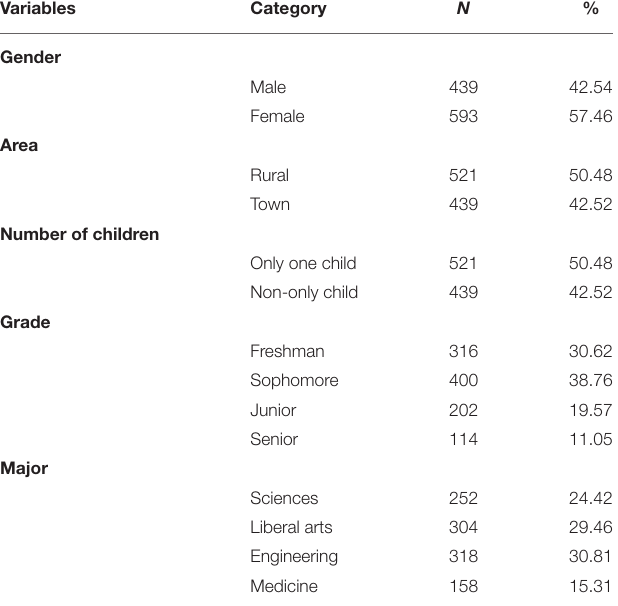
TABLE 1 | Demographic data ( N =